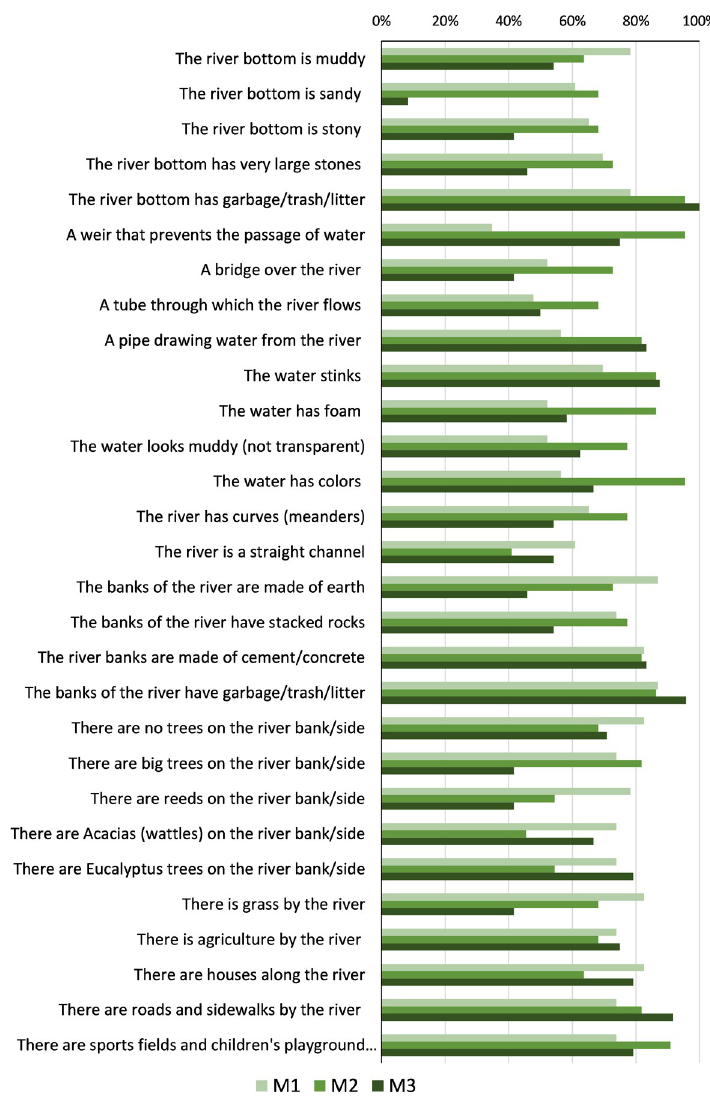
Fig 6. Proportion of students mentioning what they perceive as wrong in a river (or that shouldn’t be there) in M1, M2 and M3.